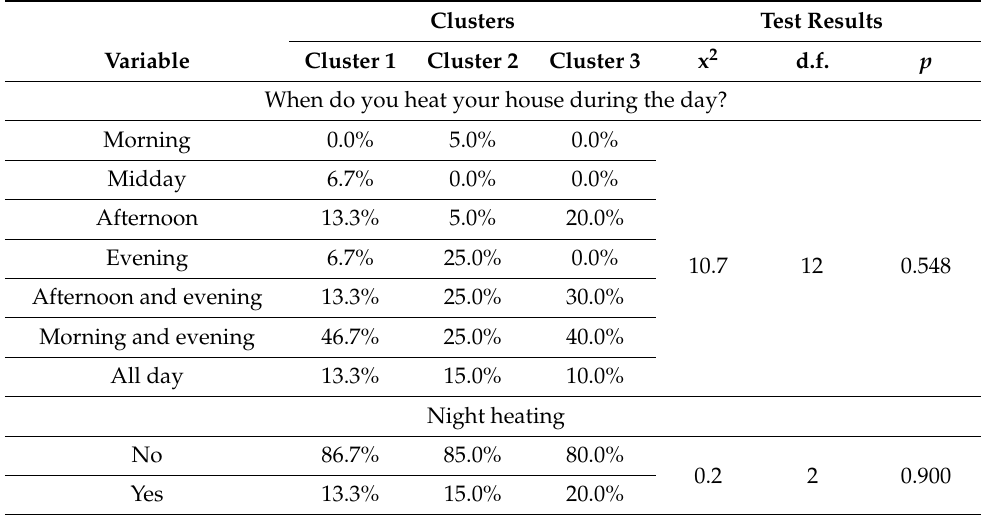
Table 14. Chi-squared analysis of occupants’ behaviours and thermal variables between clusters in